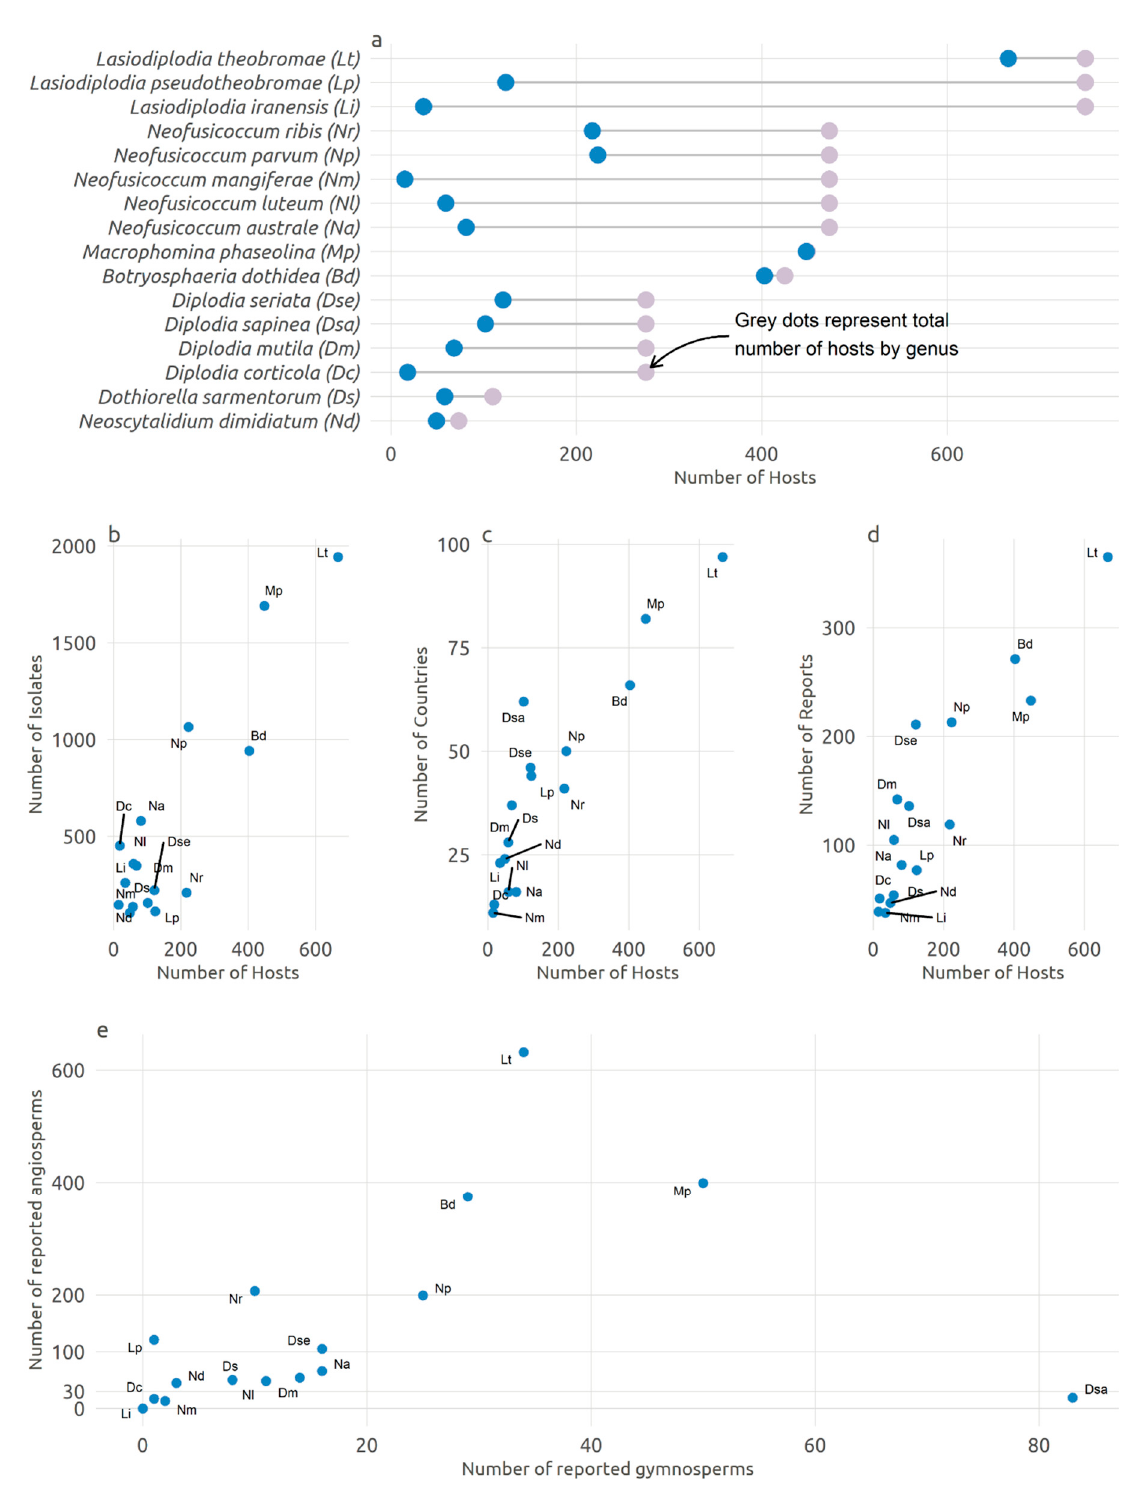
Figure 4. Host–fungus interaction overview. ( a ) Comparison of the number of hosts by species within genera, ( b ) number of isolates versus number of hosts, ( c ) number of countries vs. number of hosts, ( d ) number of reports vs. number of hosts, and ( e ) number of known host associations with angiosperms vs. gymnosperms. Data were collected from GenBank and a literature review. Only host–fungus interactions identified at the species level were selected.